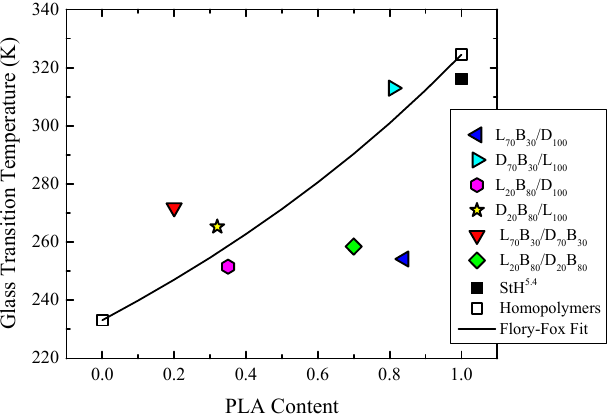
Table 5. Enthalpy of fusion, glass transition, and melting temperature of PLA stereocomplexes during the first heating, cooling, and second heating at 20 °C/min.